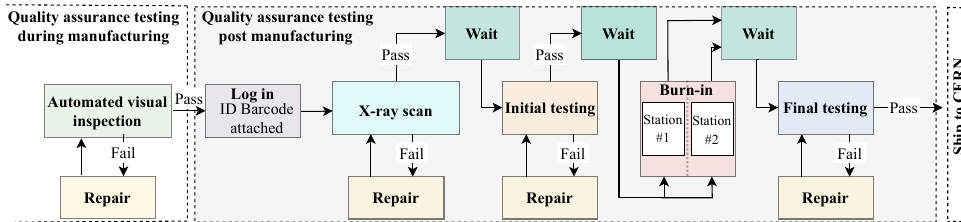
Figure 3. Functional block diagram of the LVPS Brick quality assurance